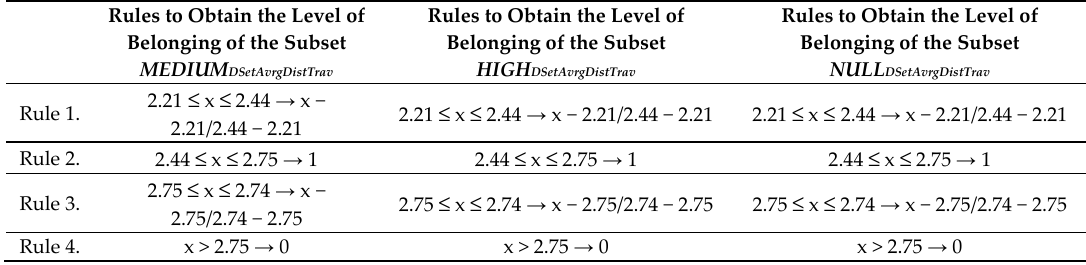
Rules to Obtain the Level of Belonging of the Subset HIGH DSetAvrgDistTrav